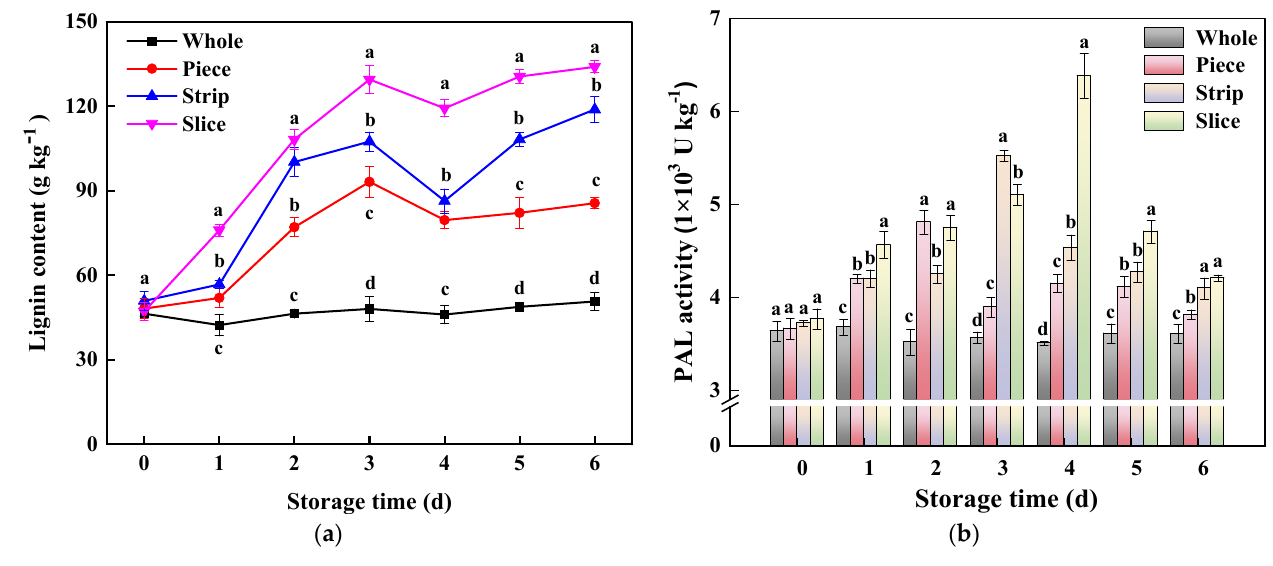
Figure 4. Effect of wounding intensities on lignin content ( a ) and phenylalanine ammonia-lyase (PAL) activity ( b ) of fresh-cut pumpkin during storage at 4 °C for 6 days. Vertical bars represent the standard deviation of the mean (n = 3). Different letters indicate significant differences between the groups ( p < 0.05).